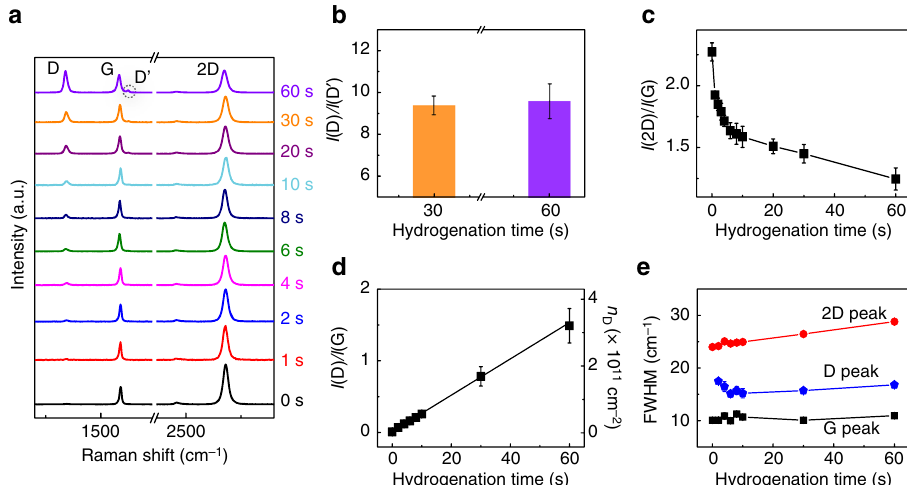
Fig. 1 Raman characterization of hydrogenated graphene. a Averaged Raman spectra of CVD graphene on a Si/SiO 2 substrate after 0-60 s of H 2 plasma (10 W, 1.0 mbar). b The intensity ratio I (D)/ I (D ′ ) after 30 s and 60 s of hydrogenation. c The intensity ratio I (2D)/ I (G) for hydrogenation times ranging from 0 to 60 s. d The intensity ratio I (D)/ I (G) and the derived defect density n D , plotted vs the hydrogenation time. The error bars include results from both exfoliated and CVD graphene. e The FWHM of the 2D, G, and D peaks vs the hydrogenation time. The spectra are recorded using a 2.33 eV (532 nm) laser excitation. The error bars in b – e are the standard deviation of experimental